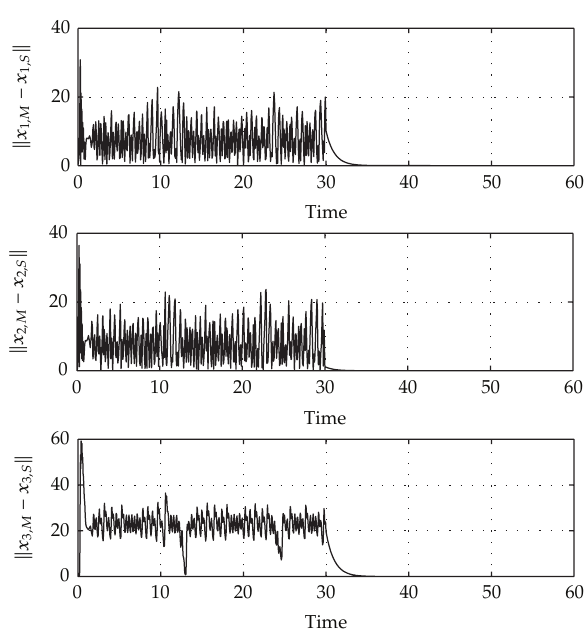
Figure 3: Stabilization of the synchronization error states at the